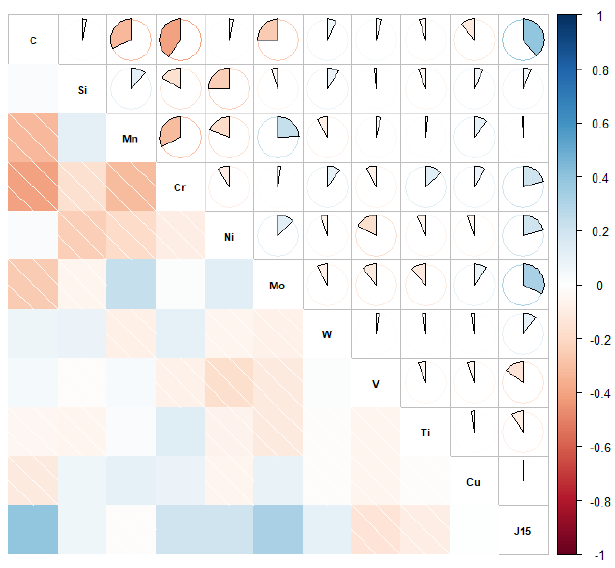
Figure 2. Pearson correlation map of hardenability and chemical elements.